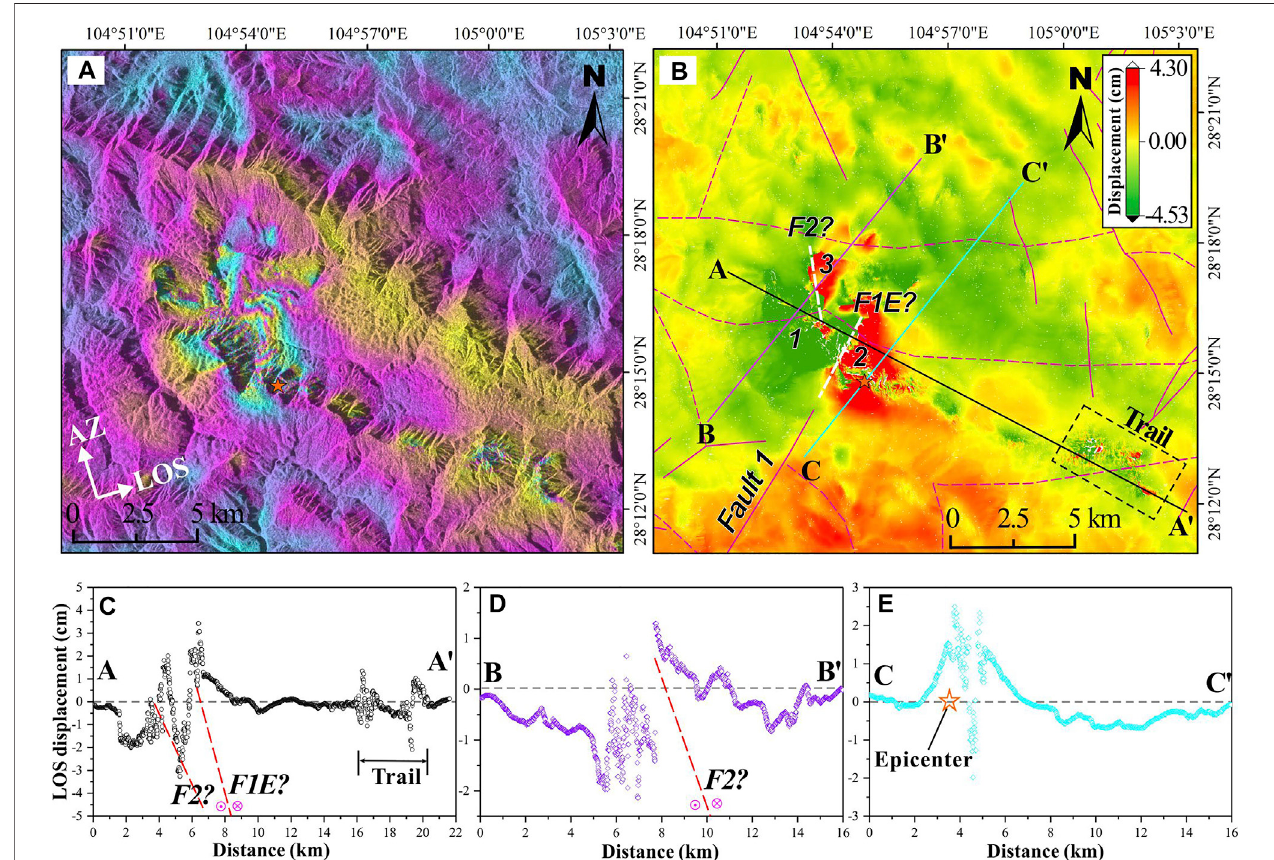
FIGURE 2 | Coseismic deformation fi eld of the “ 12.16 ” Ms 5.7 Xingwen earthquake. (A) Sentinel-1A ascending interferograms. (B) Coseismic displacement fi eld from Sentinel-1A ascending oribit InSAR data. The maximum positive and negative LOS displacements are 4.30 and 4.53cm, respectively. (C , D , E) Line-of-sight (LOS) displacementsintheascendingInSARmeasurementsalongPro fi leA – A ′ (C) ,Pro fi leB – B ′ (D) ,andPro fi leC – C ′ (E) in (B) .Theorangestarrepresentstheepicenterofthe Ms 5.7 Xingwen earthquake. F1 and F2: Faults 1 and 2, respectively; F1E: Extension of Fault